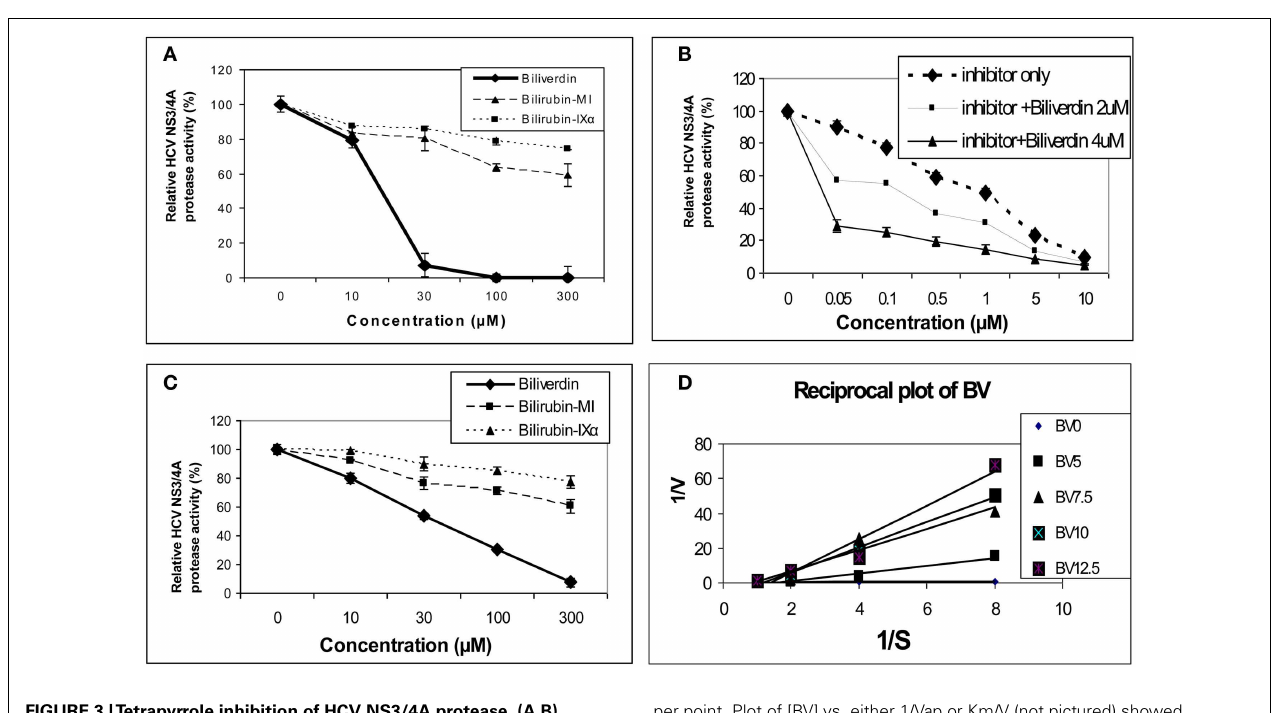
FIGURE 3 |Tetrapyrrole inhibition of HCV NS3/4A protease. (A,B) Protease activity was determined fluorometrically (FRET assay) using recombinant NS3/4A enzyme and various concentrations of inhibitors. (C) Endogenous NS3/4A protease activity in microsomes of replicons was measured using the same FRET assay but employing endogenous, partially purified NS3/4A protease from replicon cells (Zhu et al., 2010a). (D) Reciprocal (Lineweaver–Burk) plot of substrate concentration vs. enzyme activity. Recombinant protease activity was determined fluorometrically. Each point is the mean ± SEM of 3–5 determinations